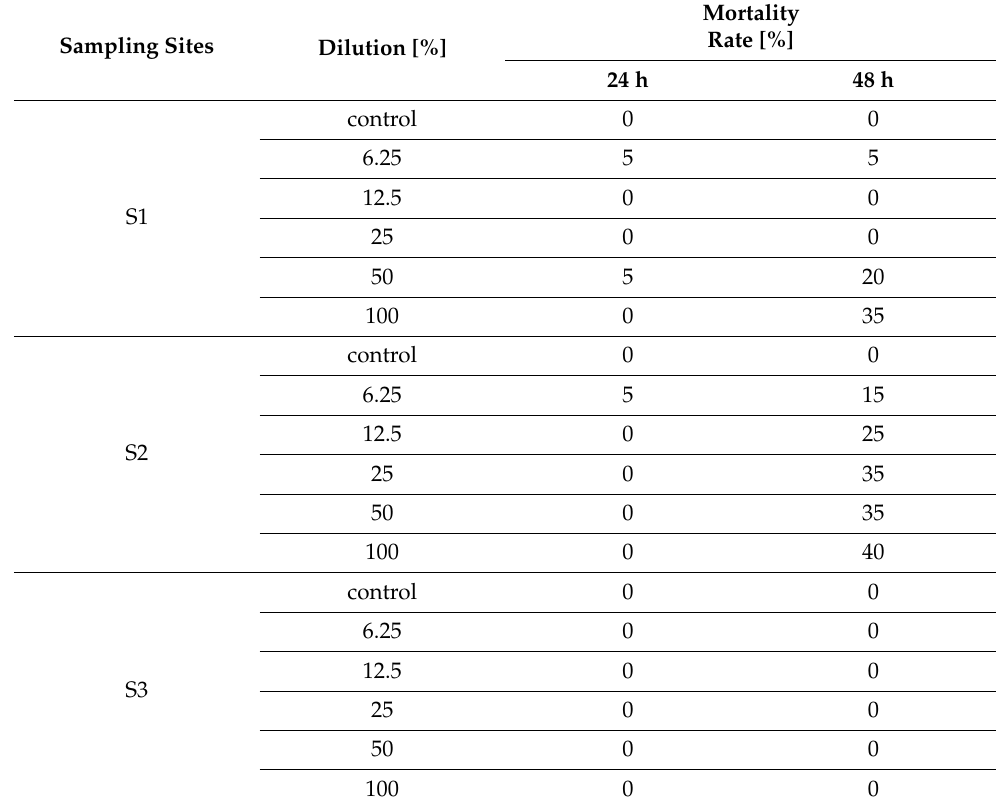
Table 6. The average mortality rate of D. magna for the studied surface water from sites S1 “Bł˛ekitna Laguna”, S2 “Huta”, and S3 “Mała Szwecja” [%].